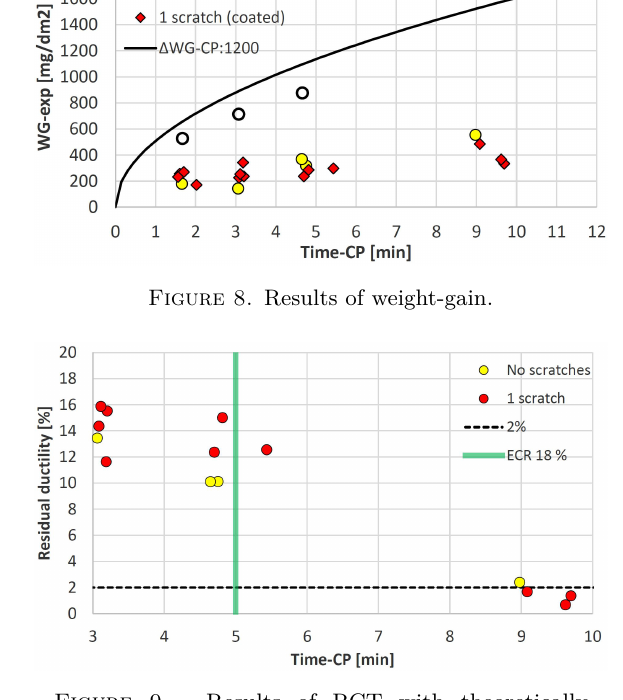
Figure 9. Results of RCT with theoretically obtained value (green) for double-sided oxidation (=